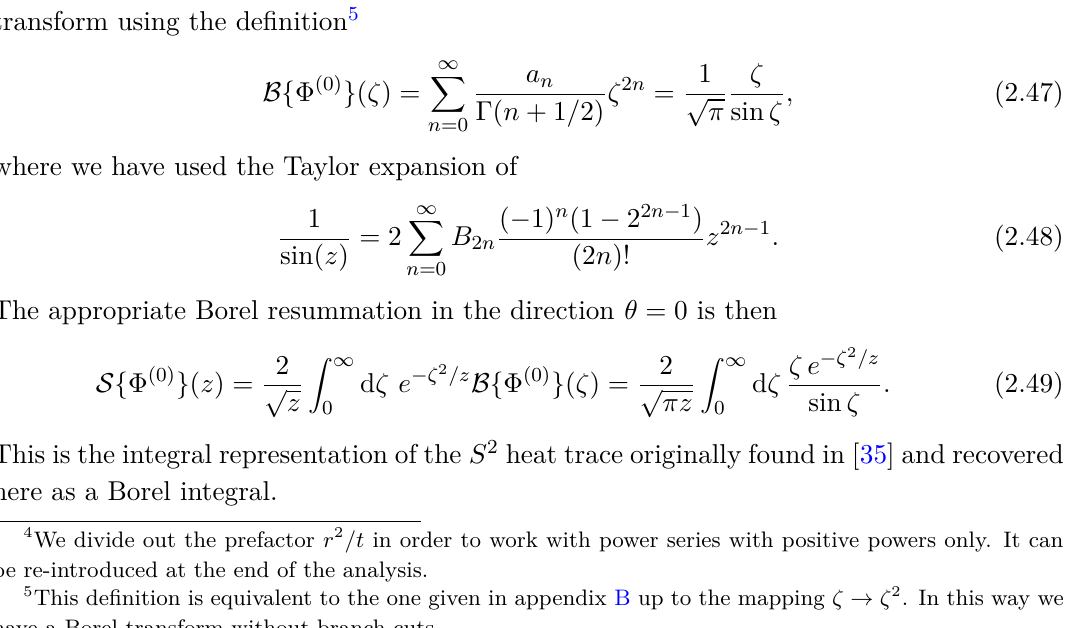
( n !) 2 , as expected from the form n ∼